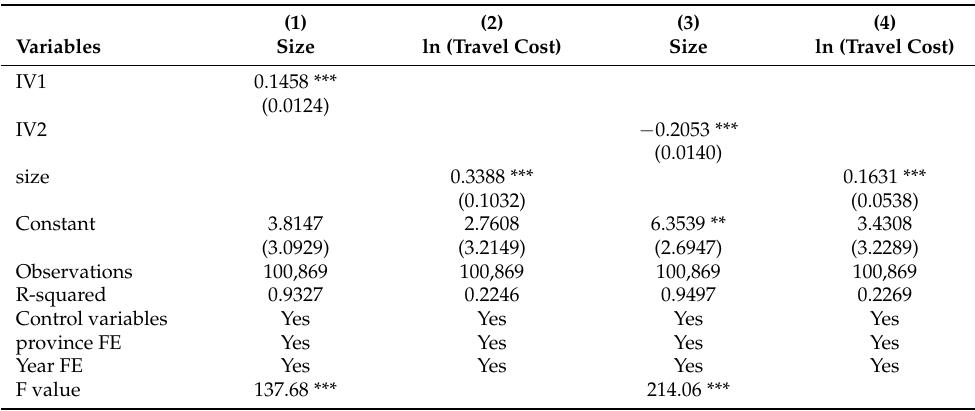
Table 4. The endogeneity test